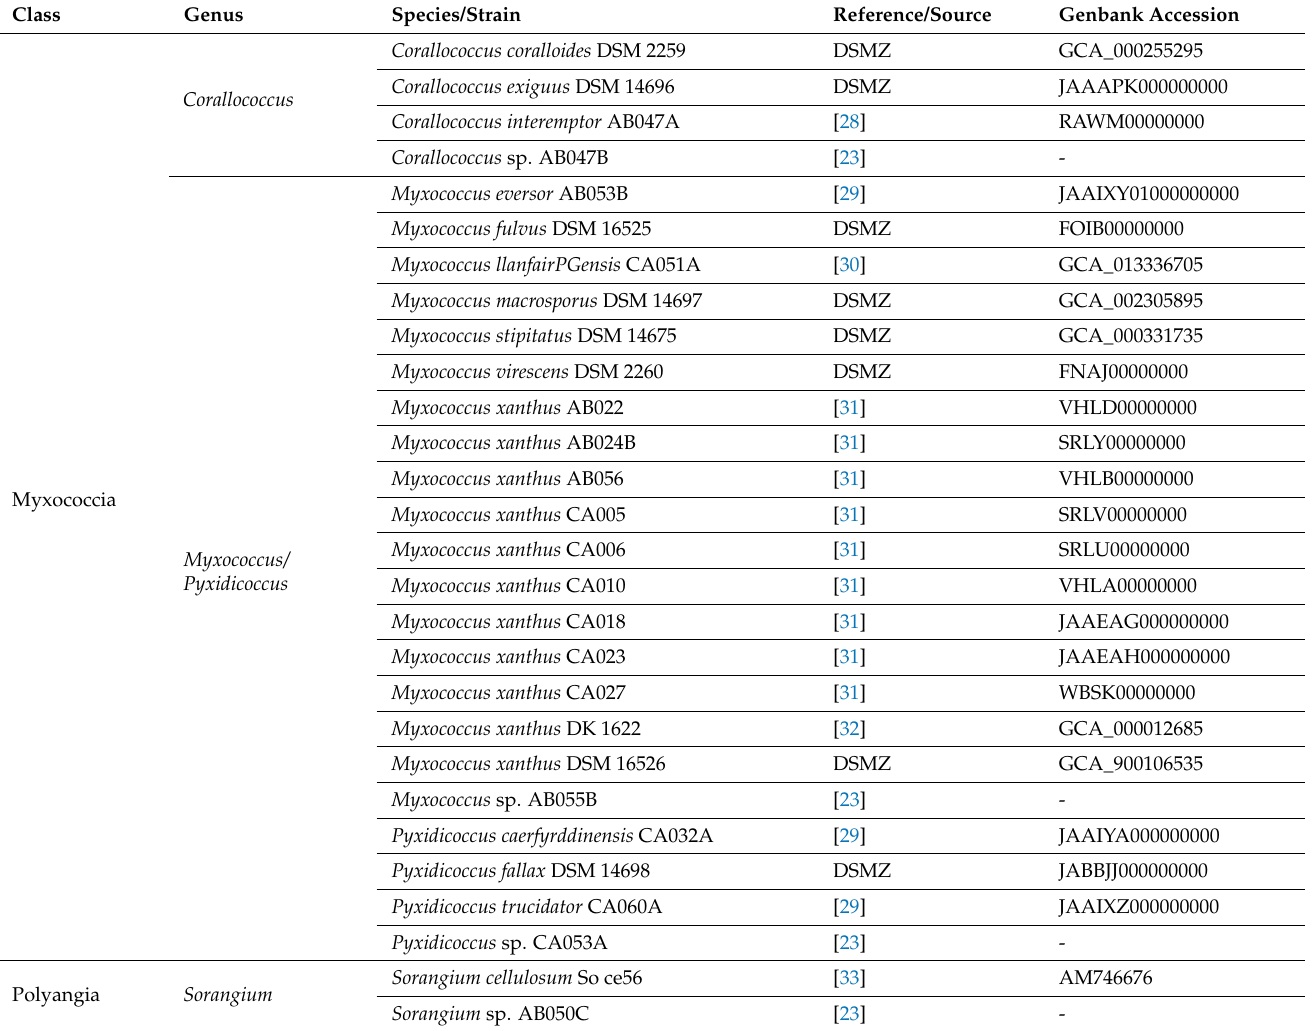
Table 1. Myxobacteria strains used. DSMZ refers to strains obtained from the German Collection of Microorganisms and Cell Cultures. Myxococcus llanfairPGensis is an abbreviation of Myxococcus llanfairpwllgwyngyllgogerychwyrndrobwllllantysiliogogogochensis . Genus Species/Strain Reference/Source Genbank